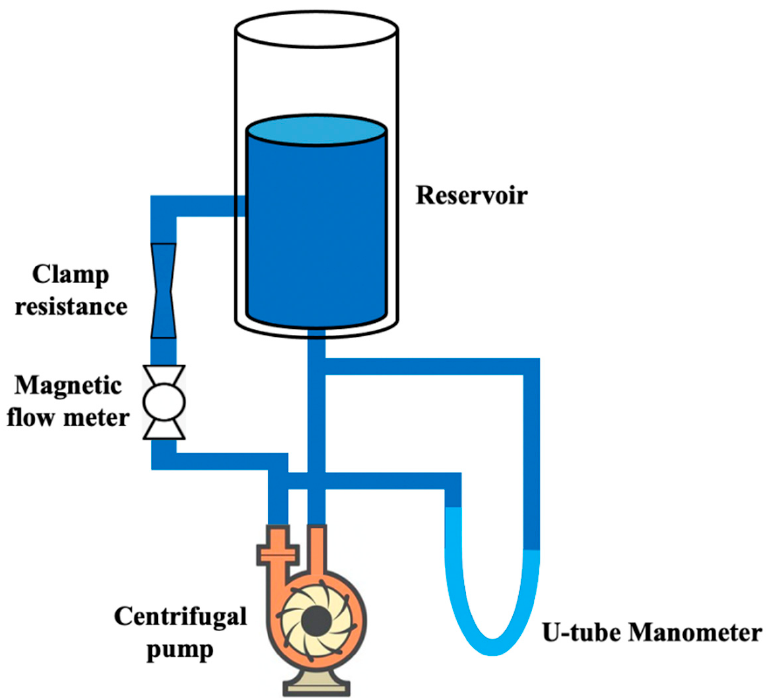
Figure 4. Example of experimental set-up for the study of device testing in [71].